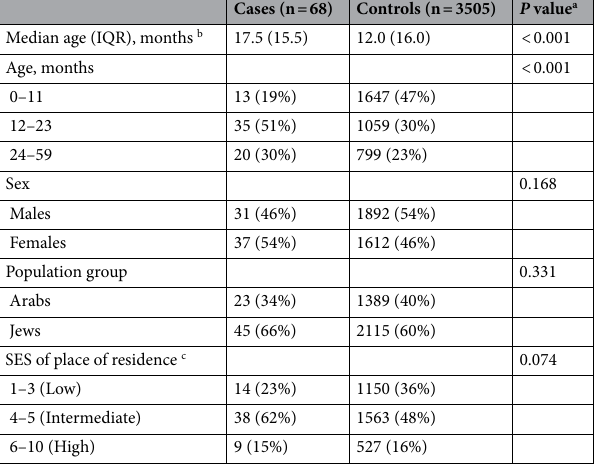
Table 1. Socio-demographic characteristics of children hospitalized for acute gastroenteritis with and without convulsions. a P value was obtained by the chi square test, unless specified otherwise. b IQR: interquartile range; P value was obtained by the Mann–Whitney U test. c SES: Socioeconomic status. Information on residential SES was missing for 7 (11%) cases and 264 (8%) controls and on sex and population group for 1 control.